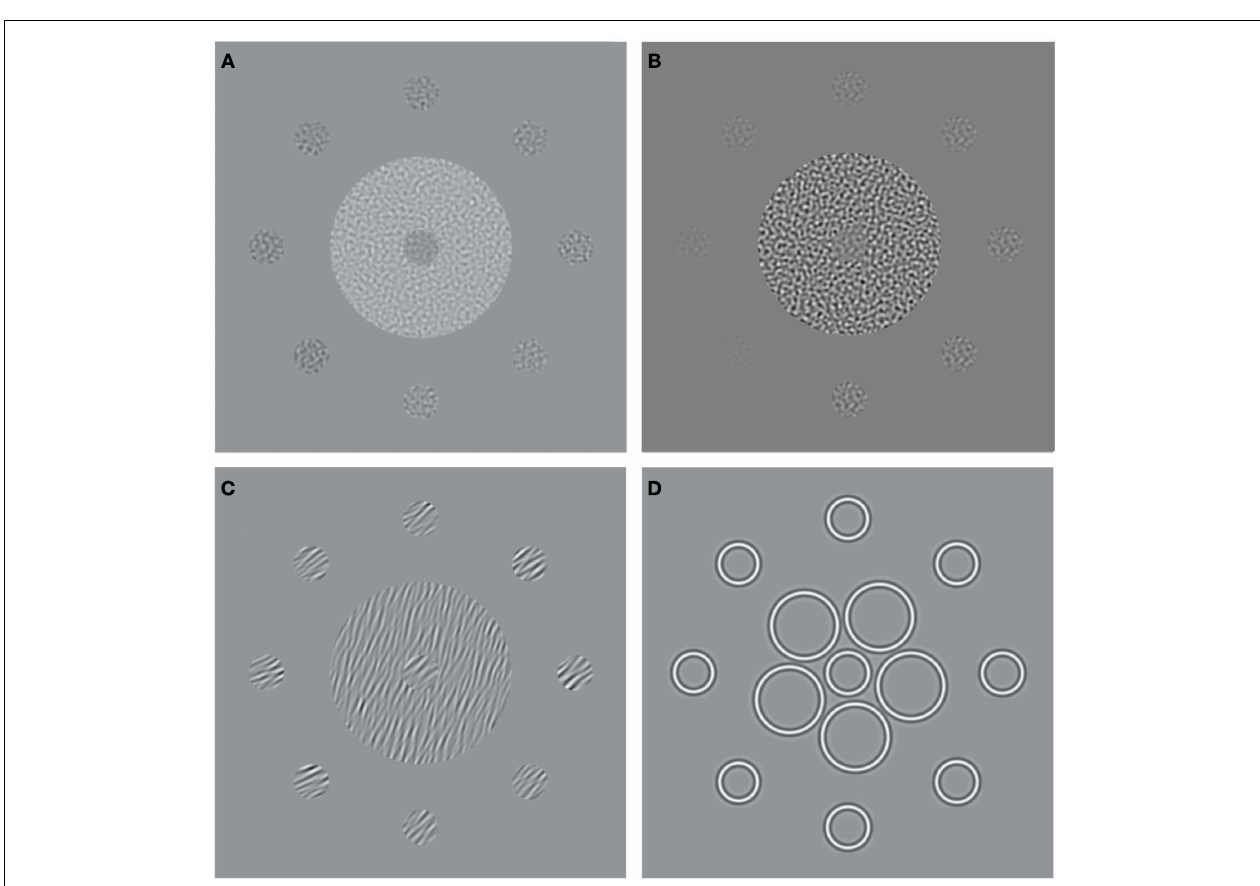
and (D) larger elements. Here, for the purpose of illustration, each stimulus is also surrounded by eight test-patches at different signal levels. A typical perceptual match to the central reference-patch is shown at “12 O’clock” whereas the true/physical match is at “6